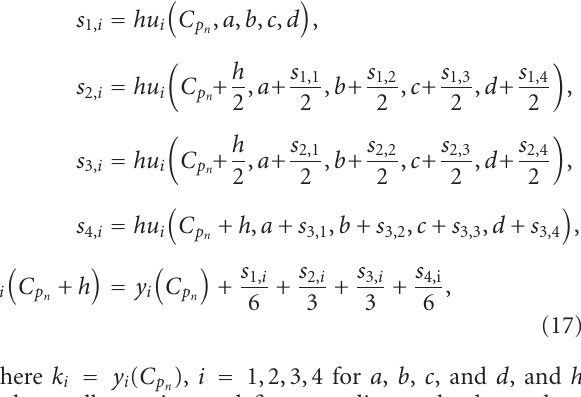
Figure 2: The input blood function.